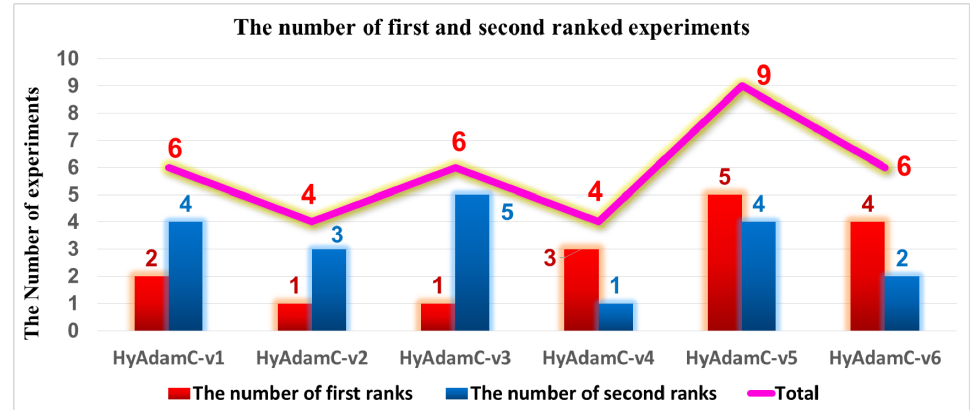
Figure 10. The number of the experiments in which HyAdamC-v1 to v6 achieved the first and second best test accuracies.